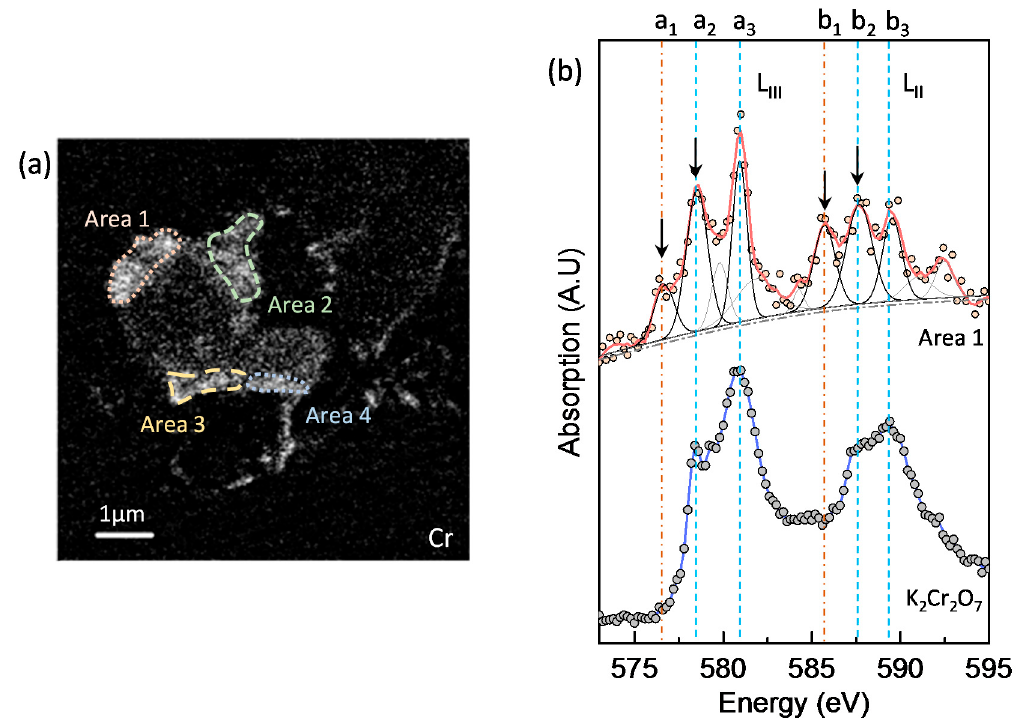
Figure 8. ( a ) Illustration of the analyzed areas in GGBS-CH-S3 for the Cr L 2,3 -edge NEXAFS in the Cr image contrast map (Figure 7b); ( b ) Cr L 2,3 -edge NEXAFS spectra for Area 1 in ( a ) and spectra from K 2 Cr 2 O 7 .